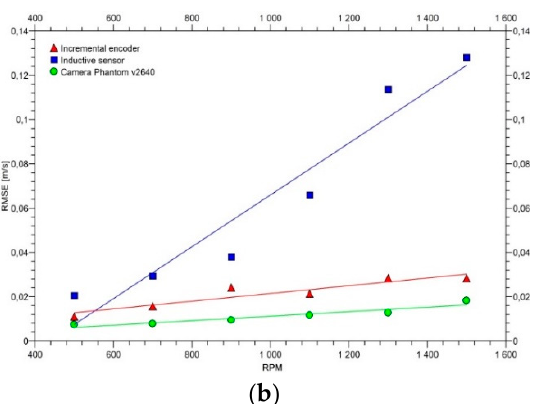
Figure 13. Errors calculated for the three selected measurement methods in the full range of the recorded revolutions per minute: ( a ) MAE, ( b ) RMSE.